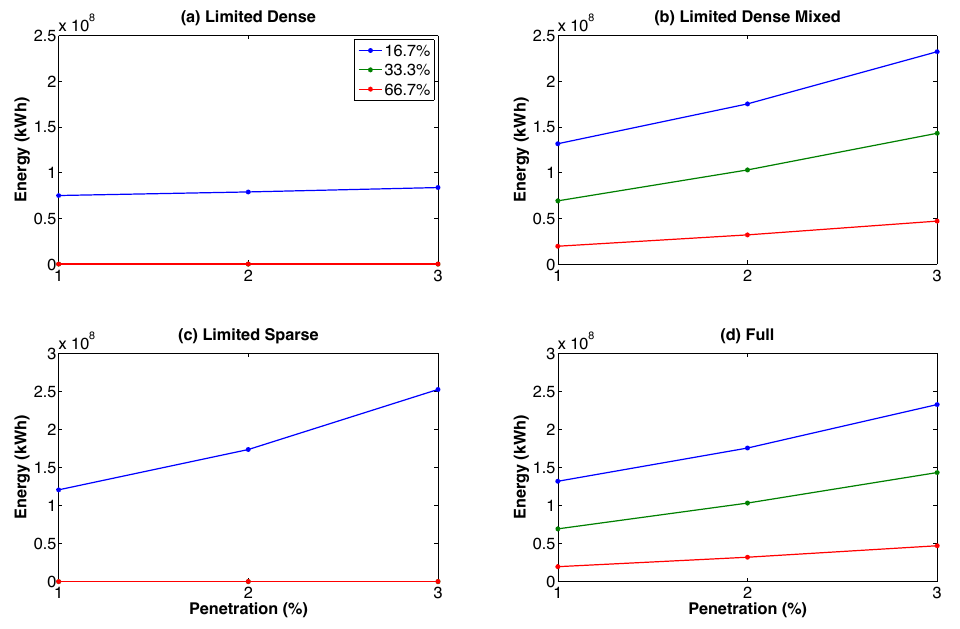
Figure 12. Safety criterion